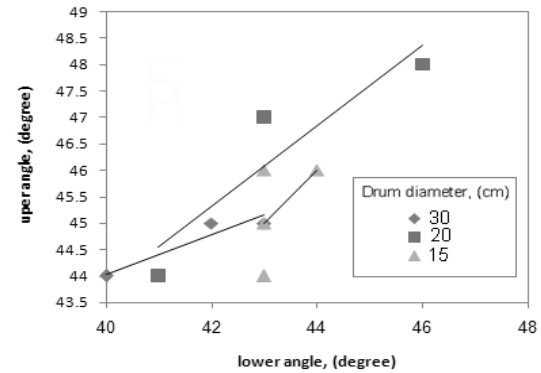
Fig. 6: The differences between lower and upper angles of repose in rice grains due to different filling degrees and cylinder diameters ranges from 1° to 4°.